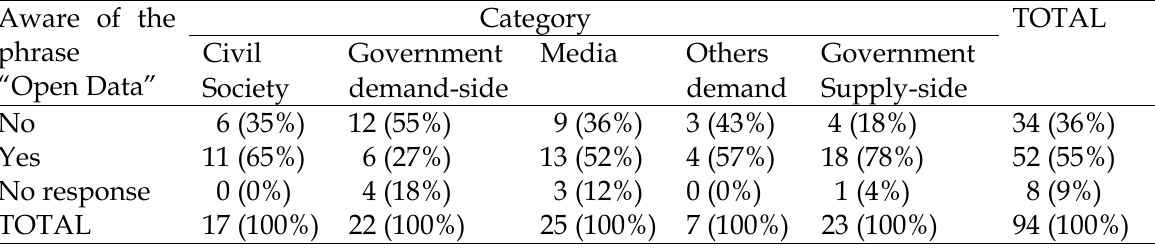
Table 1: Respondent Awareness of the Phrase “Open Data”